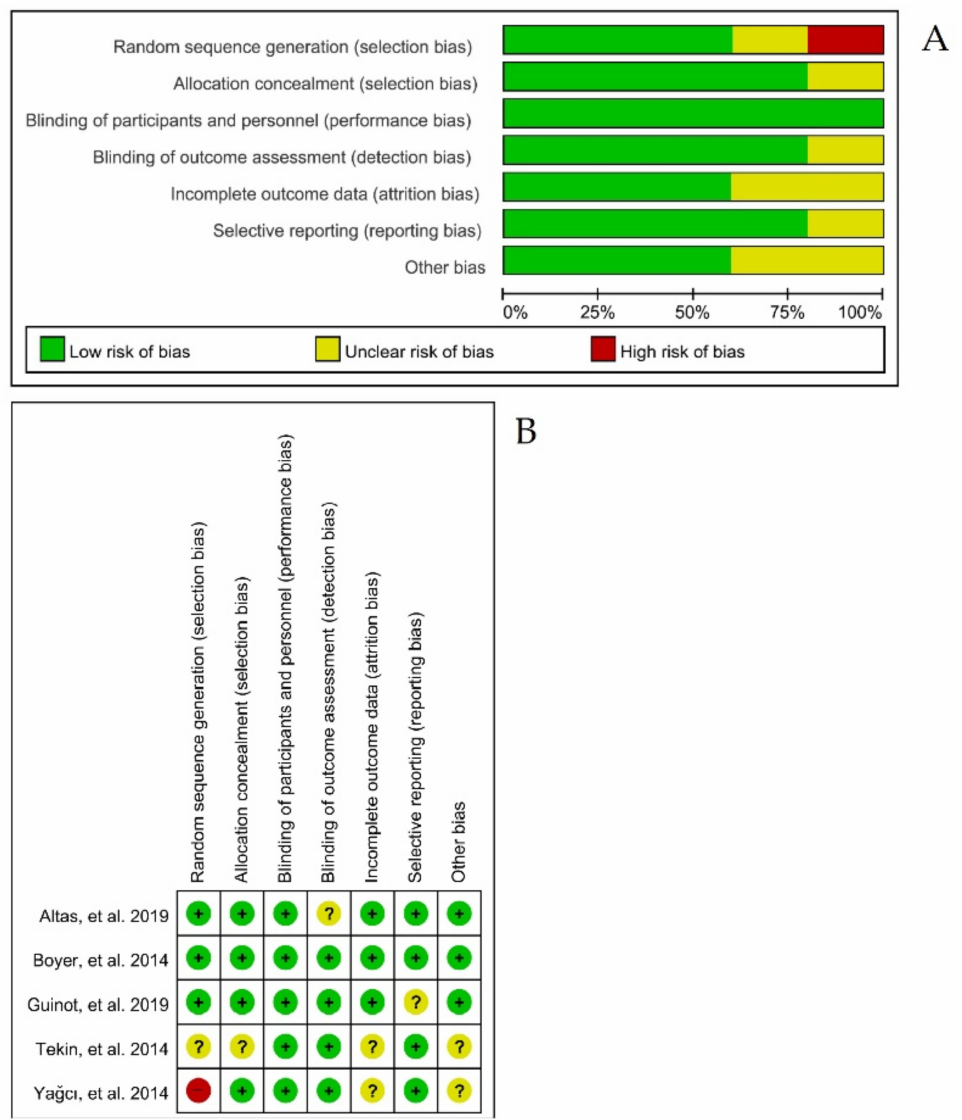
Figure 2. Risk of bias of the systematic review. ( A ) Risk of bias graph: review of the authors’ judgements about each risk of bias item, presented as percentages across all included studies. ( B ) Risk of bias summary: review of authors’ judgements about each risk of bias item for each included